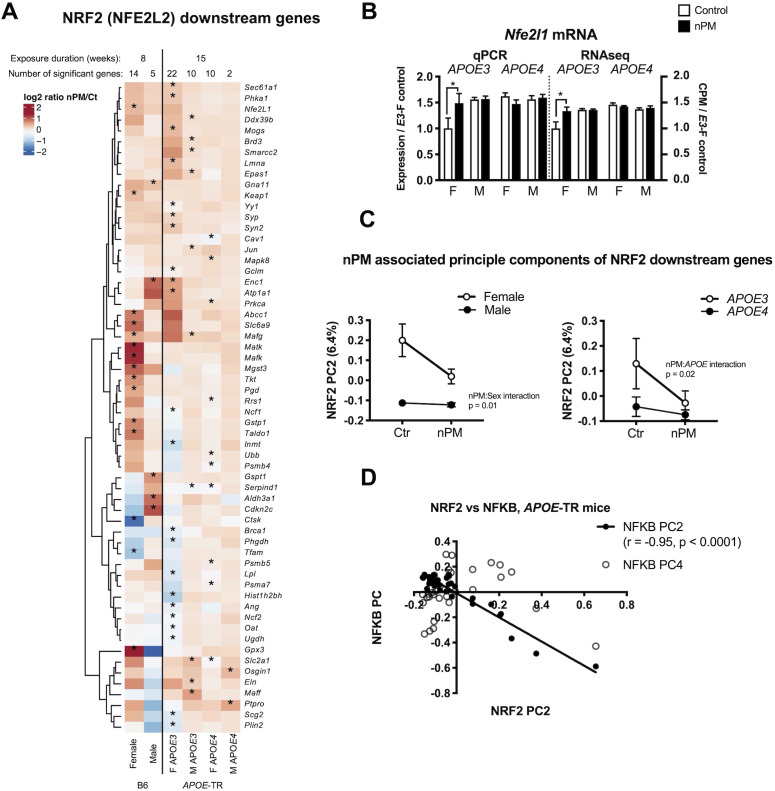
Nrf2 responses to nPM in B6 and APOE-TR mice.(A) Heatmap of log2 fold changes of nPM responses, showing altered expression of at least 60 genes downstream of Nrf2, differing by sex or APOE genotype. (B) Validation by qPCR of Nfe2l1 (Nrf1) changes in RNAseq. (C) Principal component analysis of 513 Nrf2 downstream genes in APOE-TR: Only PC2 (6.4% of variance) had nPM-sex interaction (p=0.01) and APOE (p=0.02). APOE3 females had the highest nPM response. (D) PC2 of Nrf2 downstream genes varied inversely (R2 = 0.91, p=0.0001) with the PC2 of Nfkb downstream genes. Sample size of 4/genotype/sex/treatment.